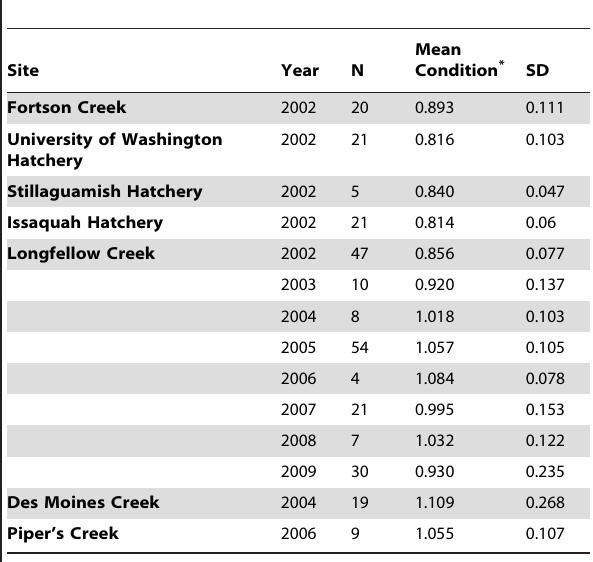
Table 3. Spawner condition for female coho salmon collected from urban and non-urban